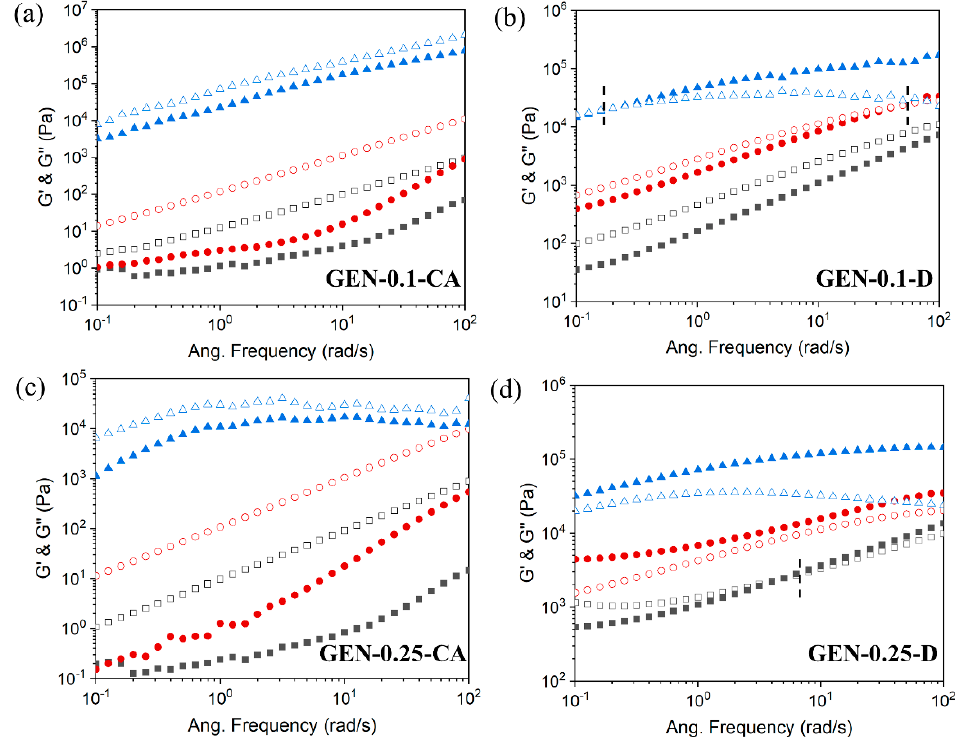
Figure 9. Storage (filled symbols) and loss (open symbols) moduli for composites of the CA and D systems at 80 °C ( ▲ ), 120 °C ( ● ), and 150 °C ( ■ ).